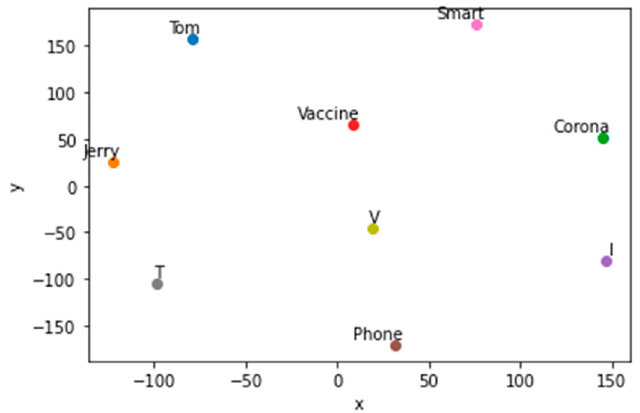
Figure 6. Embedding vector representation with W2V for sample two-term queries. Table 14. Examples of spelling variations of the terms: Corona and Iphone in the Urdu web query dataset. These variations represent coverage challenges for learning models.